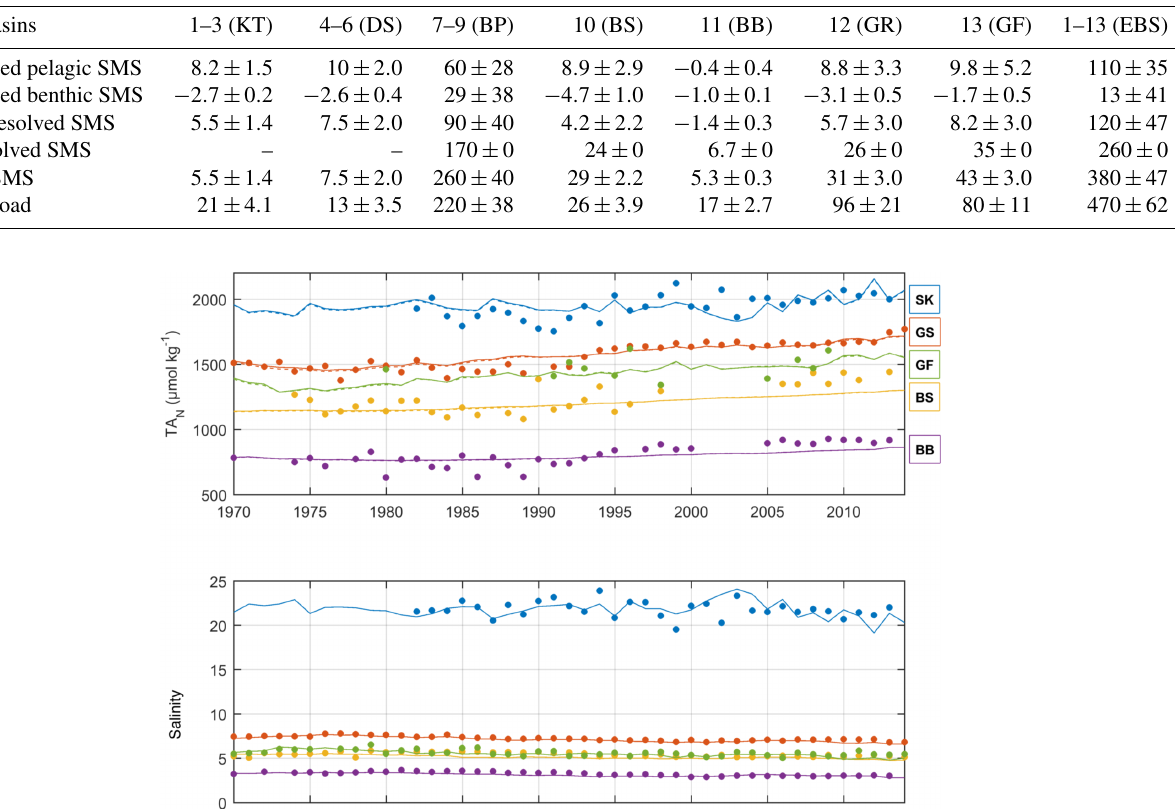
Table 5. Average resolved and unresolved TA sources minus sinks (SMS) and river loads with standard deviations (Gmolyr − 1 ) in 1970–2014 according to the BALTSEM calculations in this study. Sub-basins according to Fig. 1.